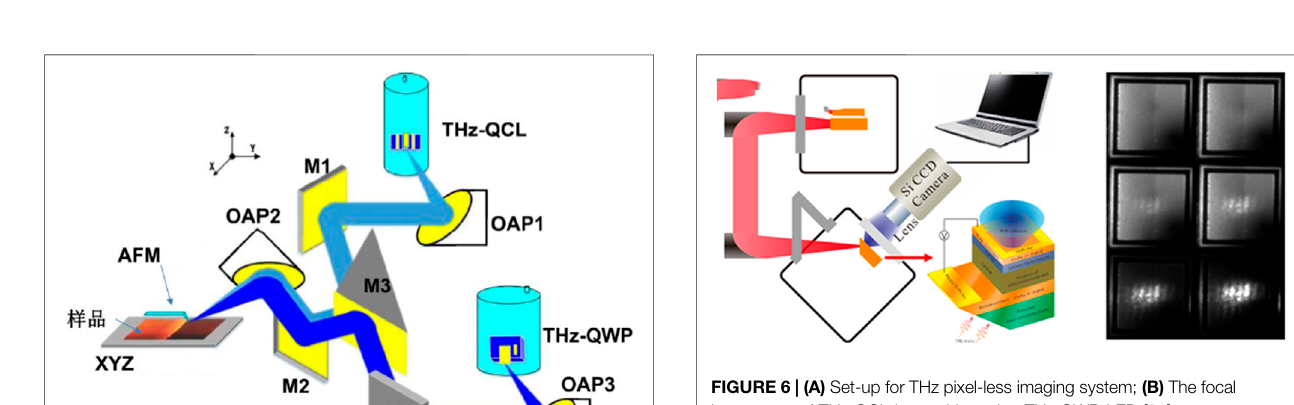
FIGURE 4 | The fast THz confocal microscopic imaging system [28].